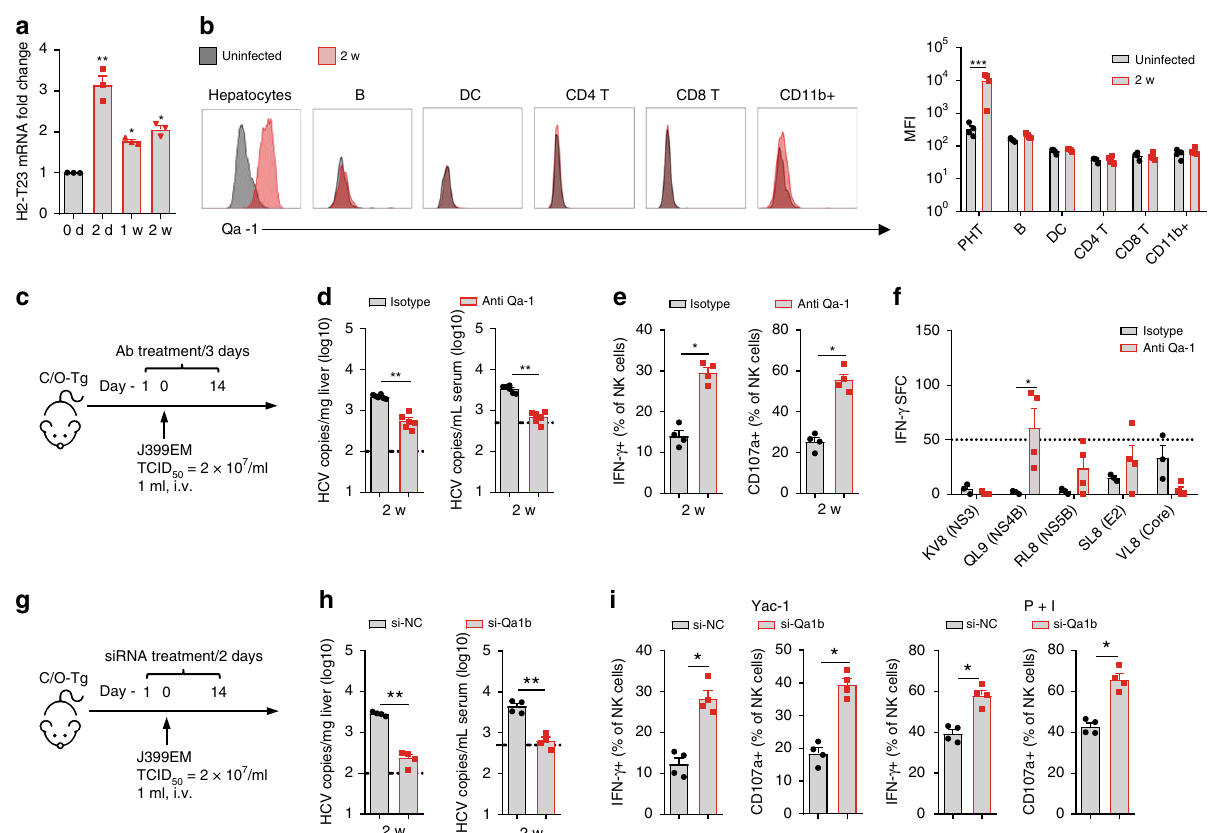
Fig. 6 Upregulation of Qa-1 on hepatocytes accounted for NK cell dysfunction upon HCV infection. a Measurement of Qa-1 mRNA in liver isolated from C/ O Tg mice ( n = 3) at the indicated time post HCV infection. b FACS analysis of Qa-1 expression on hepatocytes or NPC subsets as indicated before or 2 weeks post HCV infection. c C/O Tg mice ( n = 6 each group) were i.p with Qa-1 blocking antibody or isotype IgG (100 μ g/3 days). d HCV RNA copies in serum and liver, e CD107a and IFN- γ expression in hepatic NK cells upon Yac-1 cell stimulation, f IFN- γ ELISpot assays of T cells stimulated by the indicated epitopes, were assayed 2 wpi. g C/O Tg mice ( n = 4 each group) were i.v. injected with liposomes/siRNA complex at a dose of 2.5 mg/kg every 3 days since day − 1. Mice were killed at 2 wpi. h HCV RNA copies in serum and liver, i CD107a and IFN- γ expression in hepatic NK cells upon Yac-1 cell or P + I stimulation as indicated. Dash lines indicated limits of detection of related assays. Data were mean ± SD, Student t- test. * P < 0.05; ** P < 0.01; *** P < 0.001. ns Not signi fi cant. Source data are provided as a Source Data fi